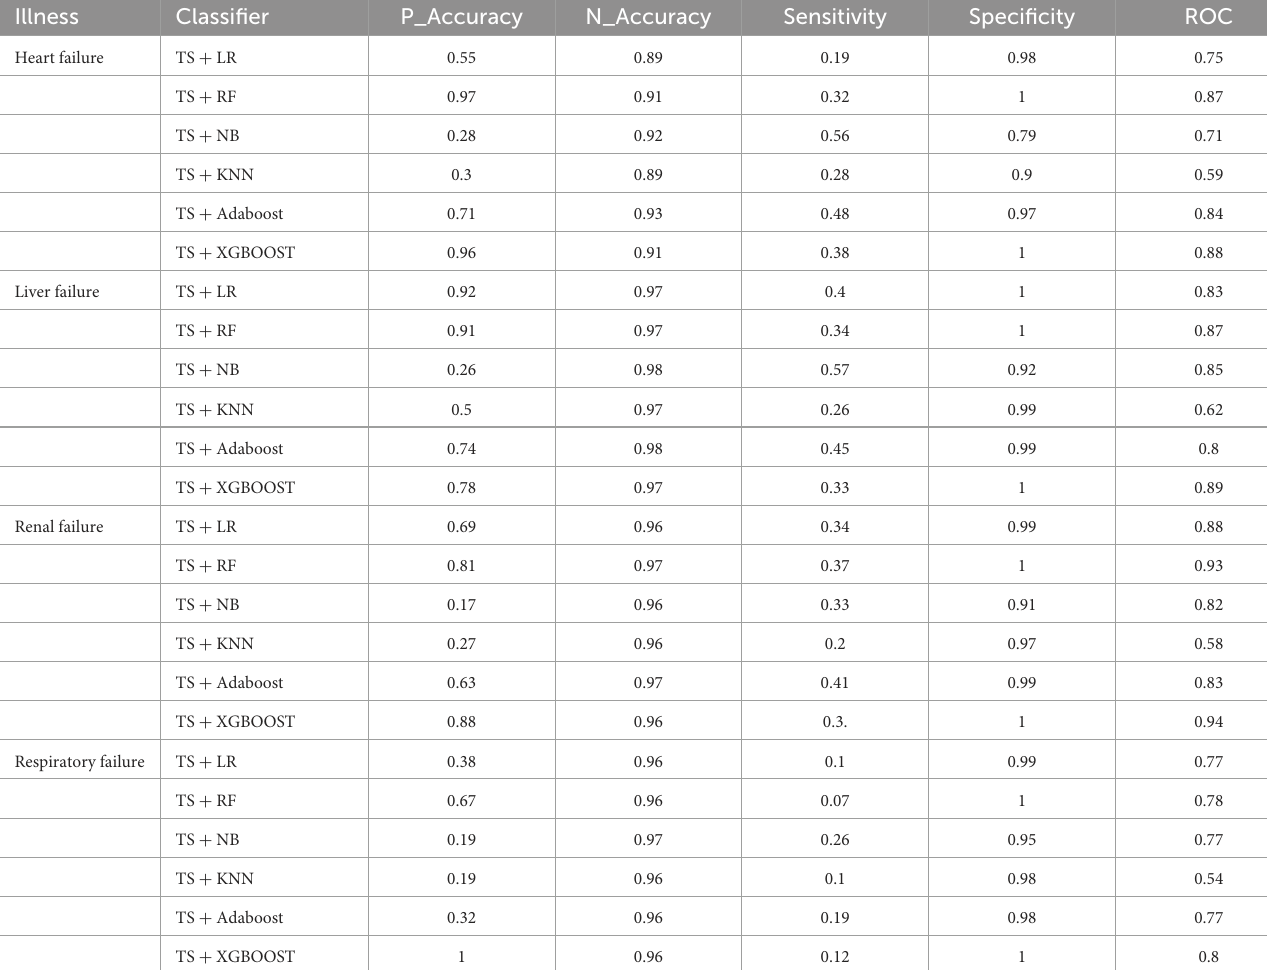
TABLE 3 Structured data experiments